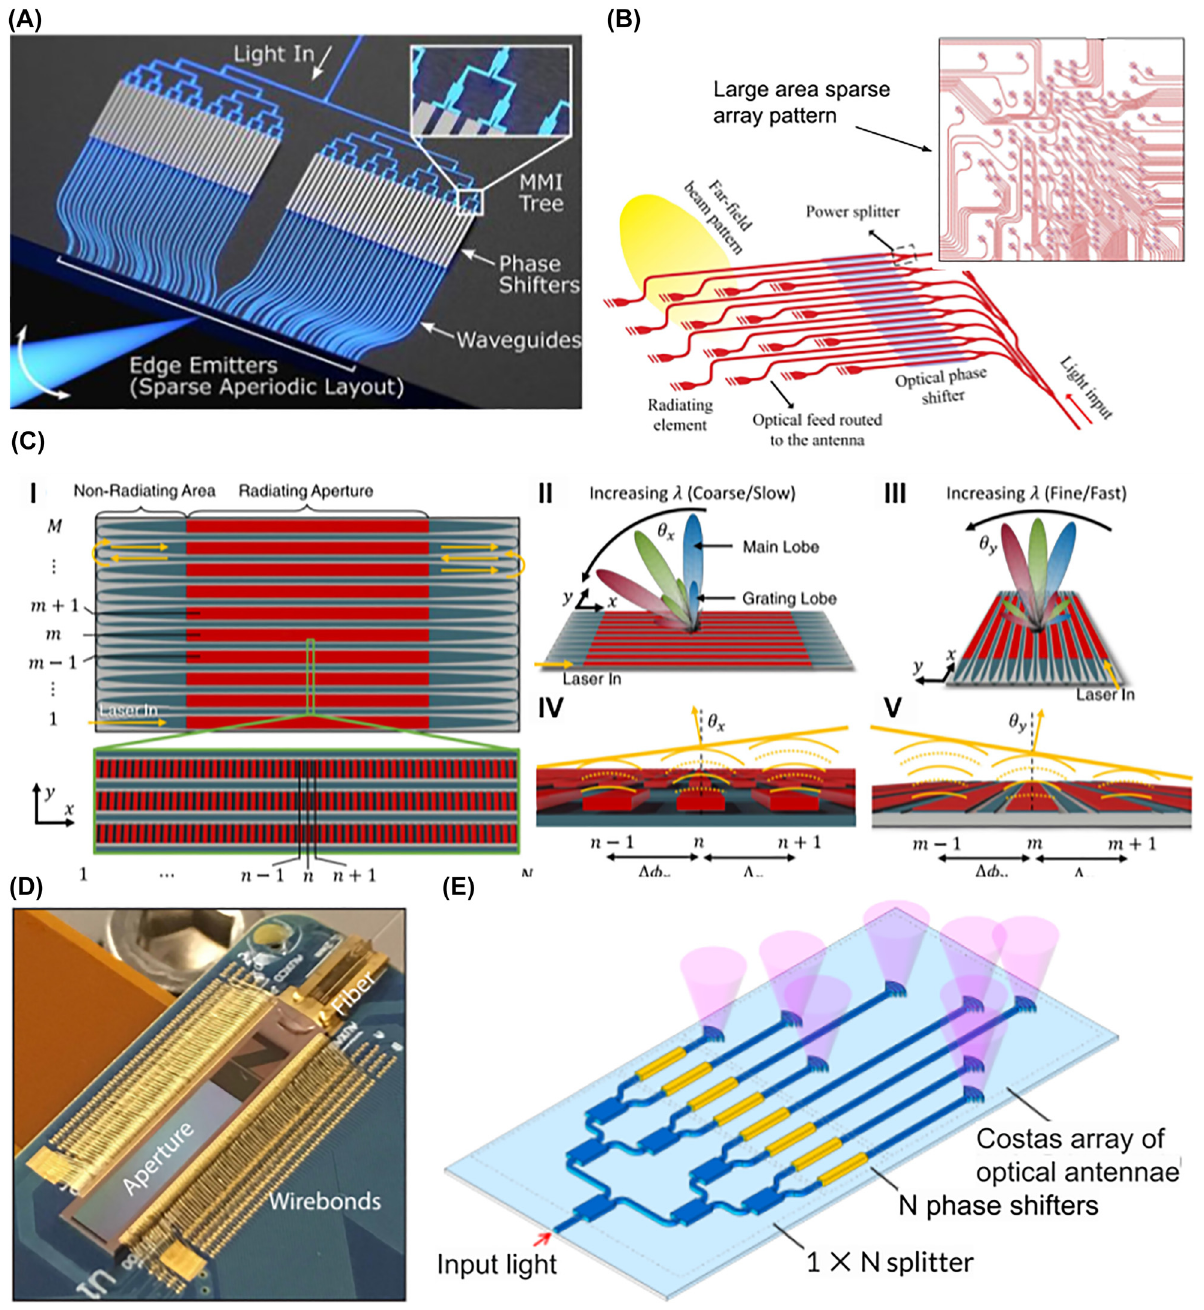
Figure 5: High performance optical phased array beam